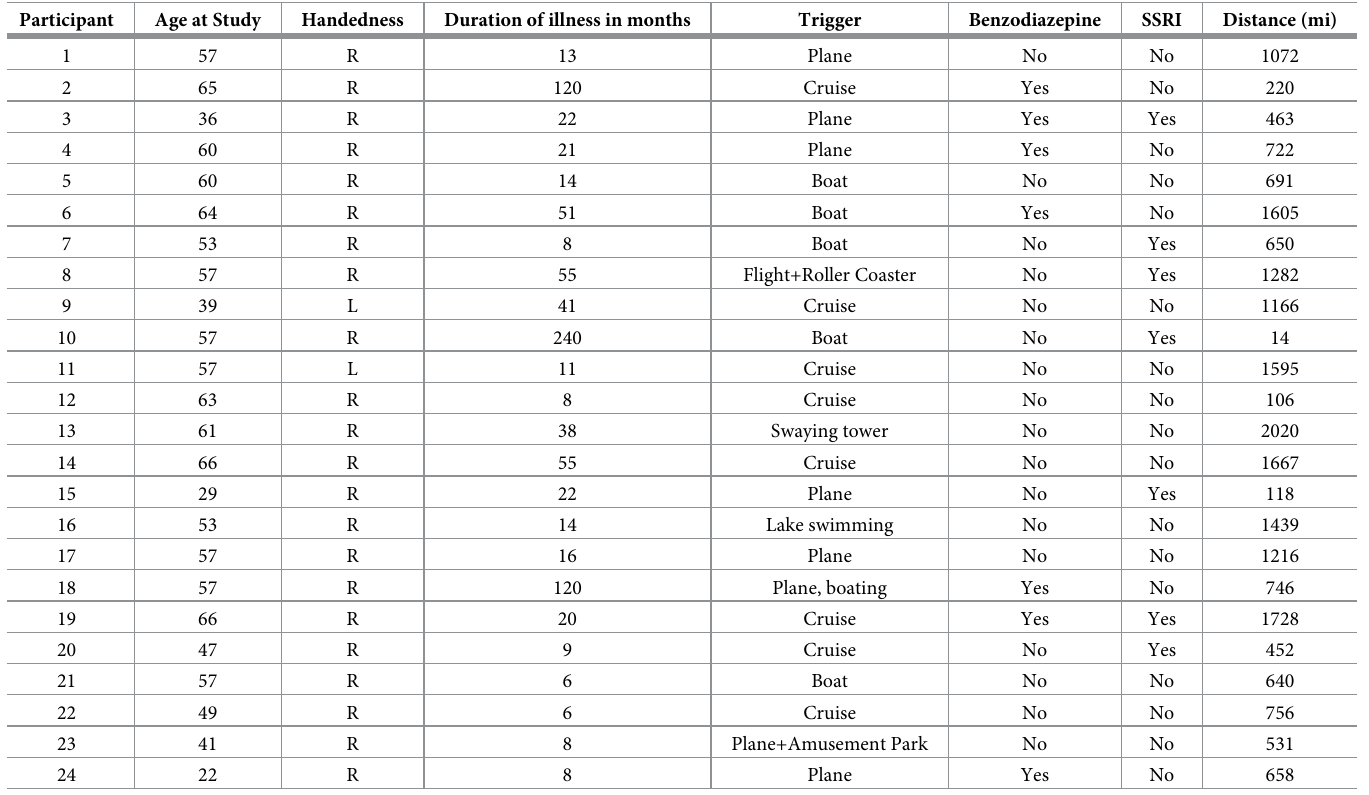
Table 1. Demographic data of study